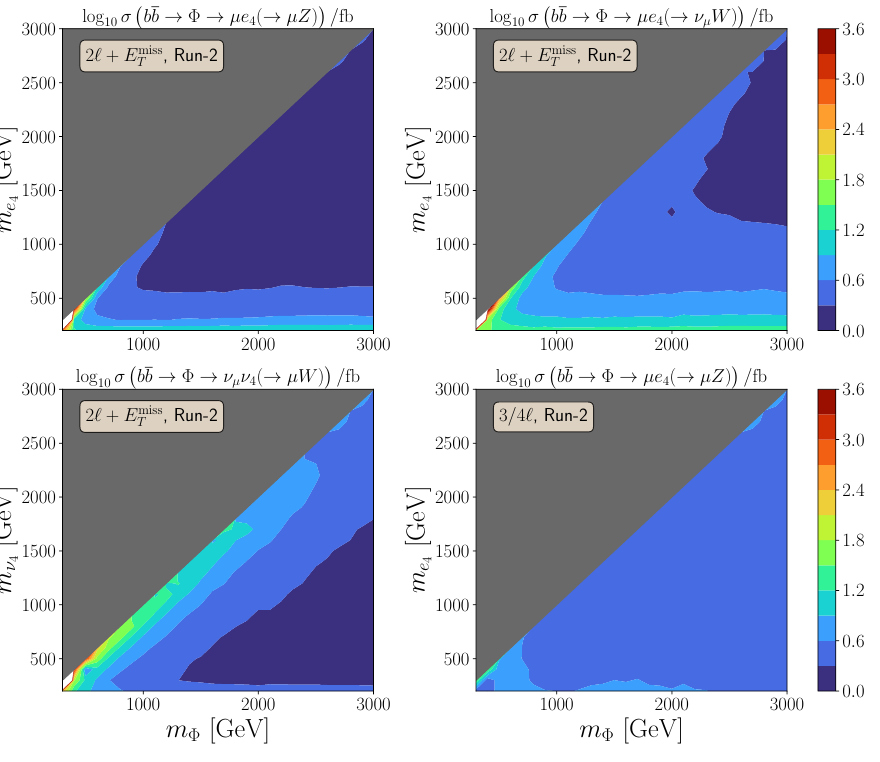
Figure 4 . Current upper bounds on σ ( bb → Φ → ‘‘ 4 ( → ‘ 0 V ))